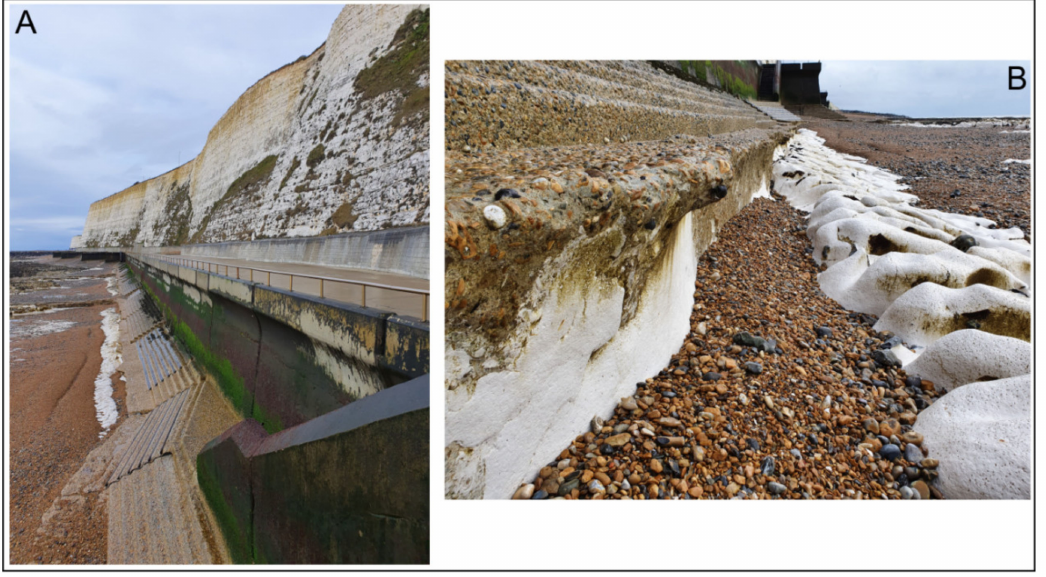
Figure 7. Undercli ff Walk in Saltdean. Photograph ( A ) shows the splash wall, undercli ff walk, seawall with small steps and the shingle beach in front of the steps. Photograph ( B ) presents part of the seawall directly on the shingle beach. Downwearing and erosion at the seawall steps have exposed the base of the seawall foundations and the underlying chalk. The bottom step has a slightly concave shape from continuous wave